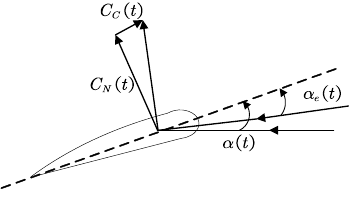
Figure 4. Actual angle of attack (AOA).